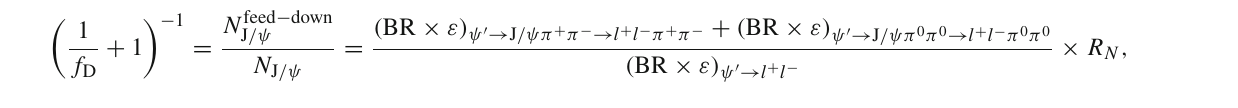
as described in the text. Right: Transverse momentum distribution of ψ (cid:2) candidates in the mass range quoted in the figure (around the ψ (cid:2) nominal